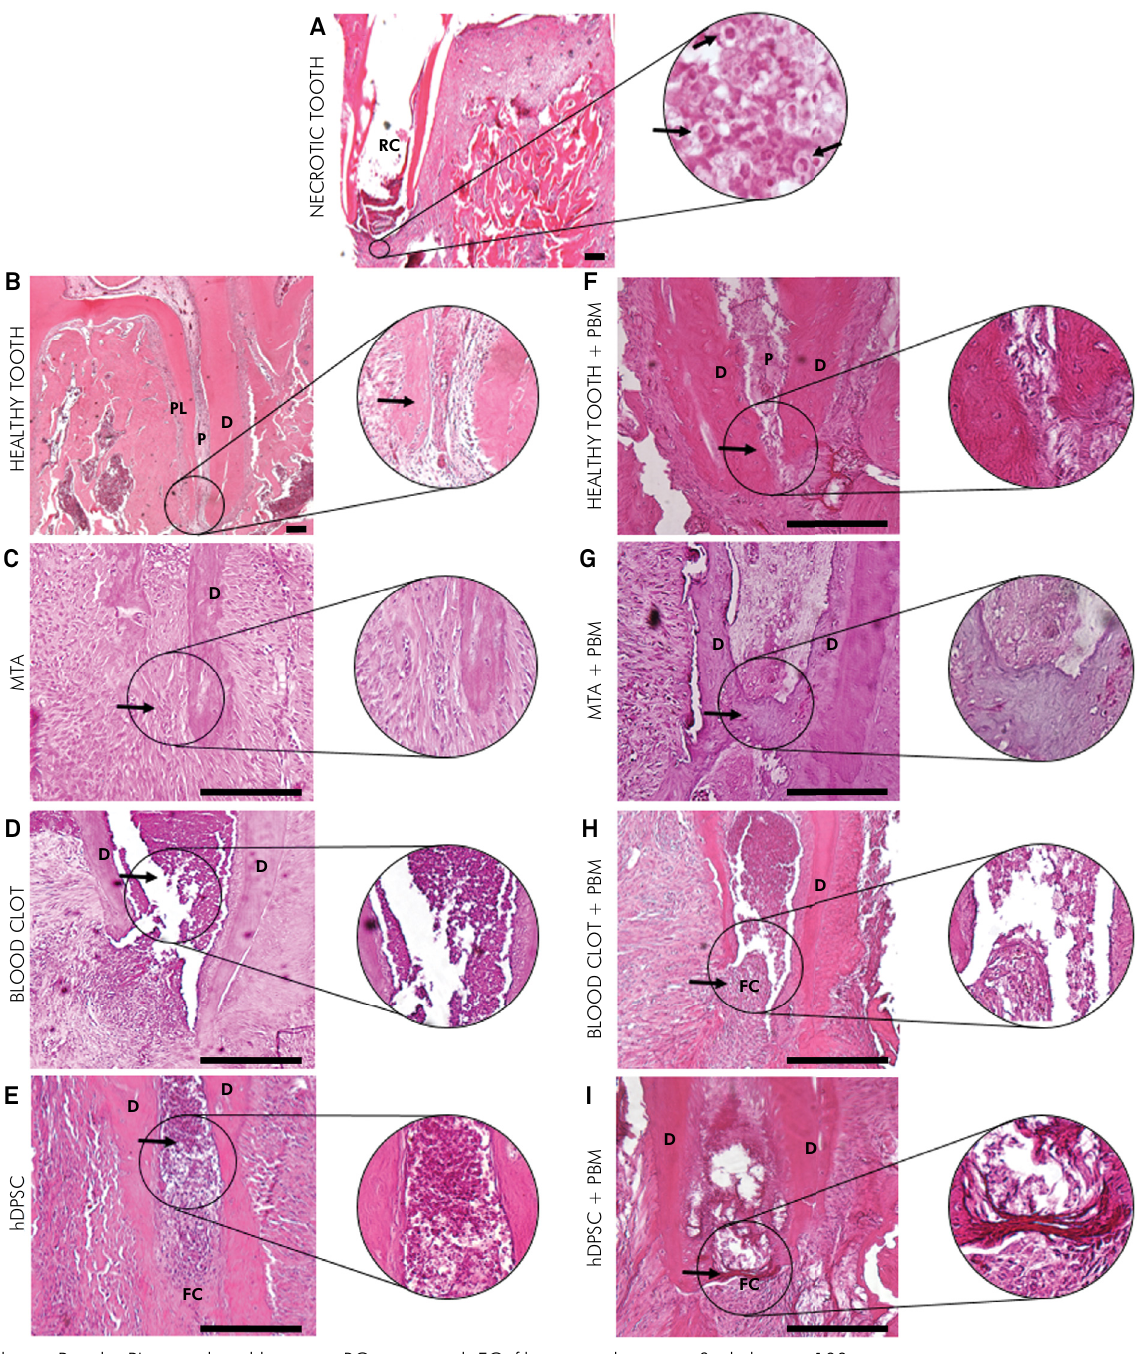
Figure 4. Histological aspects of each group. (A) Necrotic tooth group. Moderate neutrophil infiltrate (arrows) (H&E, 40x magnification). (B) Healthy tooth group. Natural root formation (arrow) (H&E, 40x magnification). (C) MTA group. Thin layer of fibrous condensation in the periapical area (arrow) (H&E, 200x magnification). (D) Blood clot group. Cell concentration of blood clot in the root canal (arrow) (H&E, 200x magnification). (E) hDPSC group. Presence of transplanted cells within the root canal (arrow) (H&E, 200x magnification). (F) Healthy tooth+PBM group. Natural root formation exhibiting complete root development (arrow) (H&E, 200x magnification). (G) MTA+PBM group. Formation of mineralized barrier (arrow) (H&E, 200x magnification). (H) Blood clot+PBM group. Thin layer of fibrous condensation in the periapical area (arrow) (H&E, 200x magnification). (I) hDPSC+PBM group. Presence of mineralized tissue on root canal walls (arrow) and thin layer of fibrous condensation in the apical portion (asterisk) (H&E, 200x magnification). Disc-shaped images represent higher magnification: 1000x (A) or 400x magnification (B, C, D, E, F, G, H,